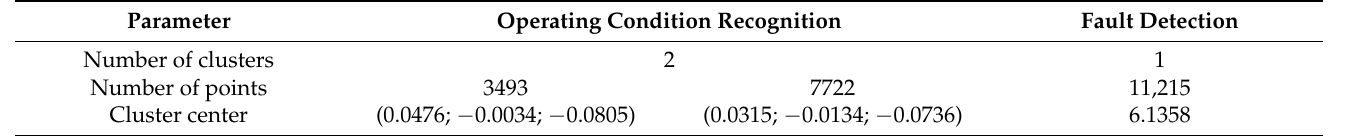
Table 3. Cluster local parameters obtained from the pretraining phase.